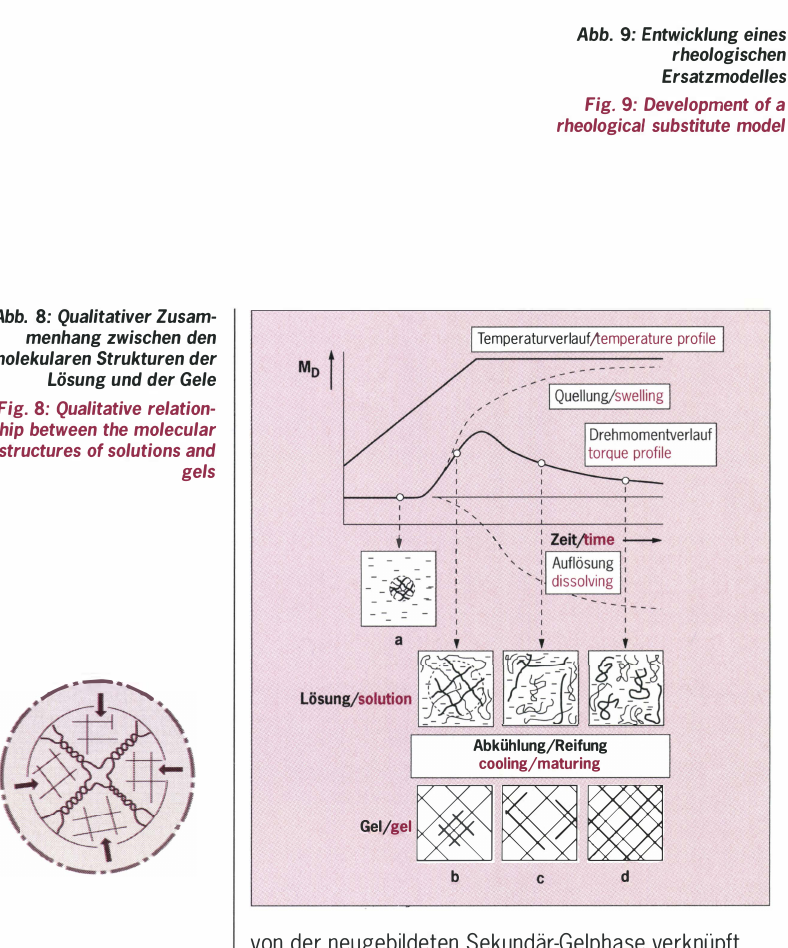
Fig. 9: Development of a rheological substitute